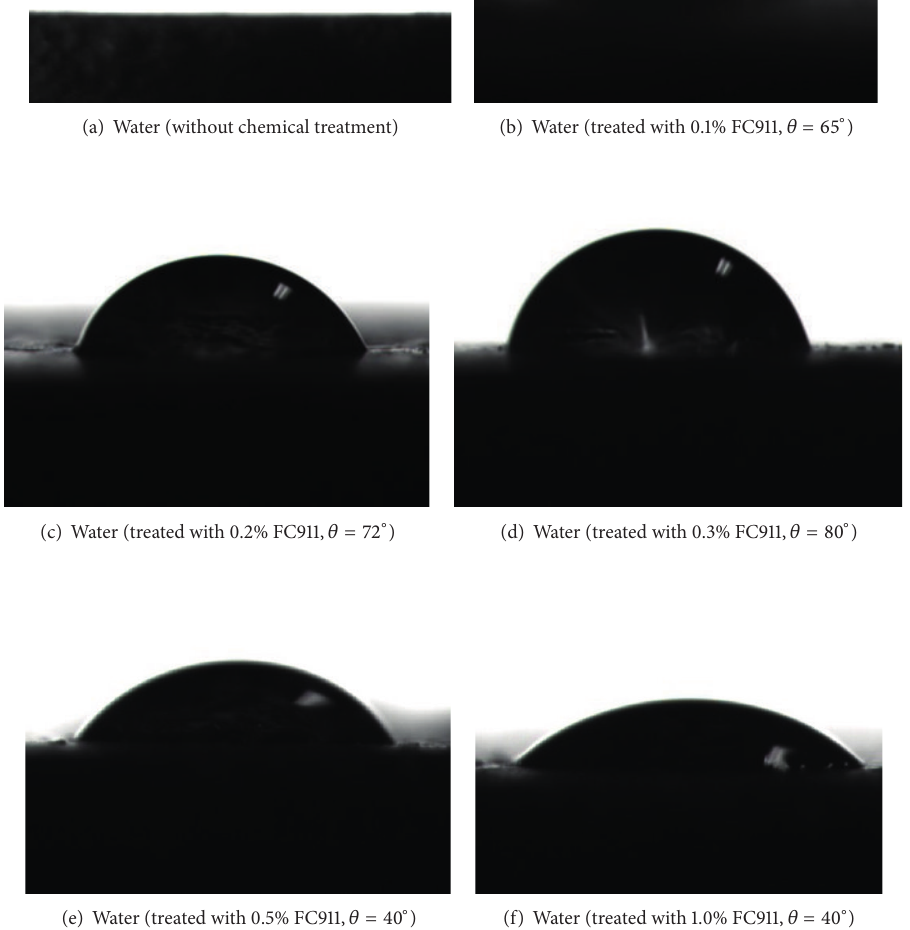
Figure 1: Water droplets on the surface of the sandstone cores before and after treatment with